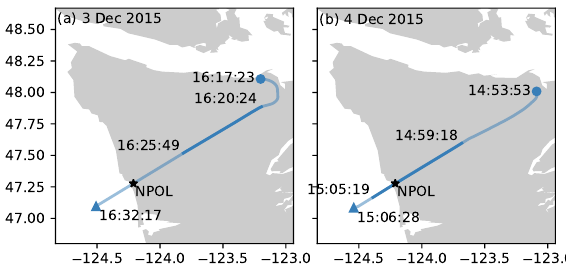
Figure 1. The paths of the flights used in Sect. 5.1 (a) and 5.2 (b) . The darker sections of the paths show the flight data used in this study (the rest of the measurements were discarded for the lack of useful data). The time stamps (UTC) denote the beginning and end of each flight and the beginning and end of the data that were used. The gray background shows the outline of the Olympic Peninsula, with Vancouver Island to the